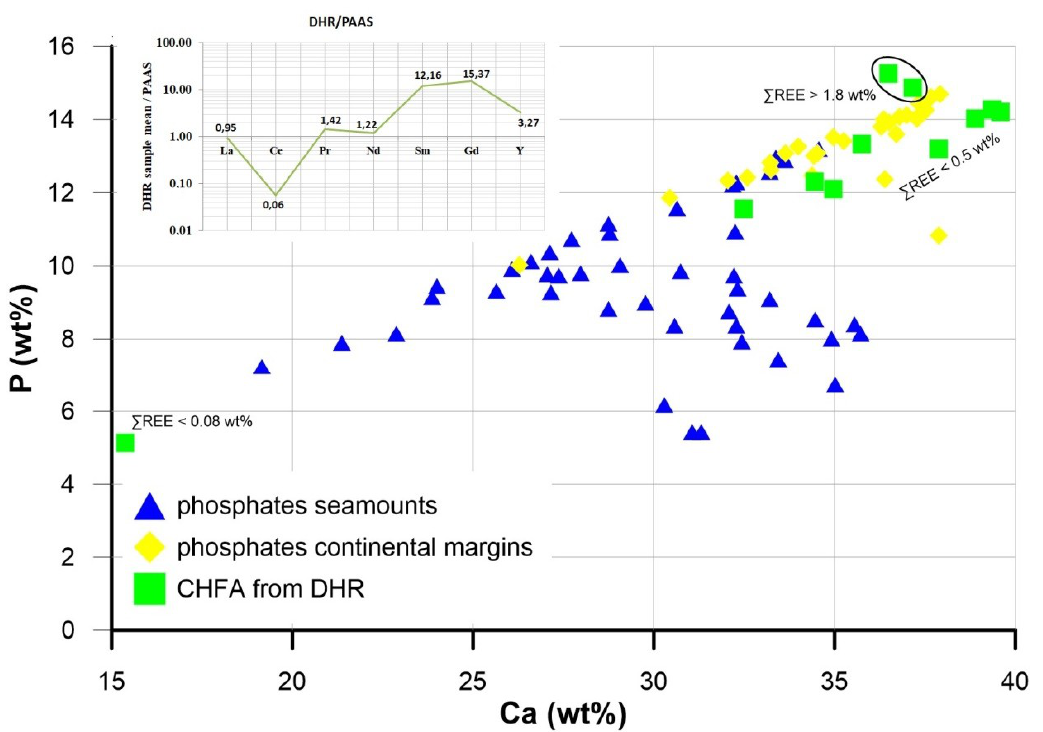
Figure 11. Scatter plot of phosphorus versus calcium in DHR Ca-hydroxyapatites. DHR crusts normalized to PAAS. Data for seamounts and continental margin phosphorite deposits from Reference [9]. The DHR data from